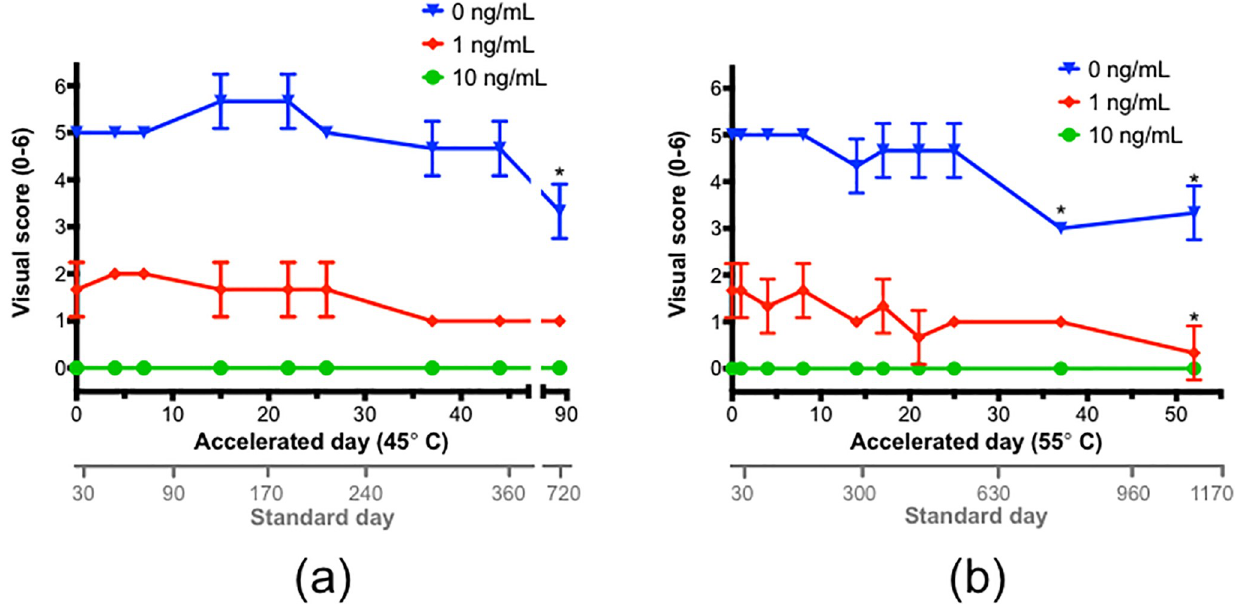
Fig 5. Shelf-life testing of the LFIA stored at (a) 45 ˚C and (b) 55 ˚C. Minimal loss of signal was observed over the course of 25 days for those tested at 55 ˚C and over the course of 44 days for those tested at 45 ˚C. The LFIA performance was tested using 3 different concentrations of α -AMA (0, 1, and 10 ng/ mL) in